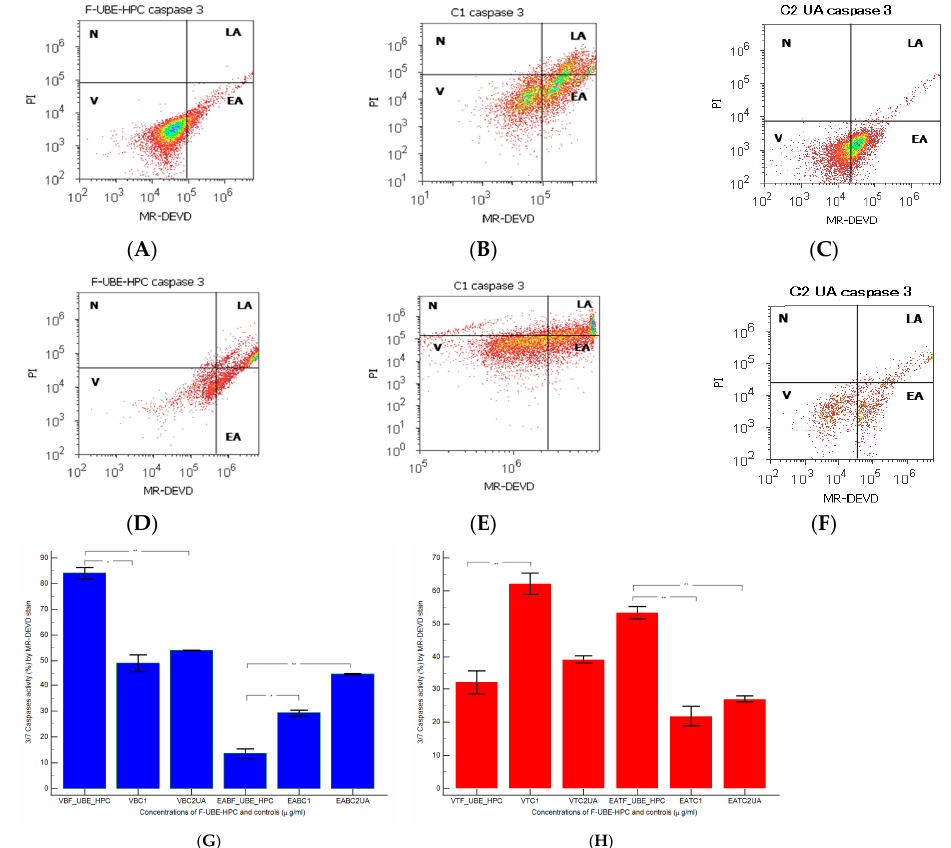
Figure 9. The activity of 3/7 effector caspases in normal blood cells ( A – C ) and CLS-354 tumor cells ( D – F ) after 24 h treatment with F-UBE-HPC; MR-DEVD patterns of F-UBE-HPC ( A , D ), 1% DMSO negative control ( B , E ); 125 µg/mL UA positive control ( C , F ). Statistical analysis of 3/7 caspases activity ( G , H ) in normal blood cell cultures ( G ) and CLS-354 tumor cell line ( H ), * p < 0.05 and ** p < 0.01 represent significant statistical differences between controls and sample made by paired samples t -test; V—viability; EA—early apoptosis; C1—negative control with 1% dimethyl sulfoxide (DMSO); C2UA—positive control with 125 µg/mL usnic acid (UA); F-UBE-HPC—bioadhesive oral film loaded with U. barbata dry ethanol extract.